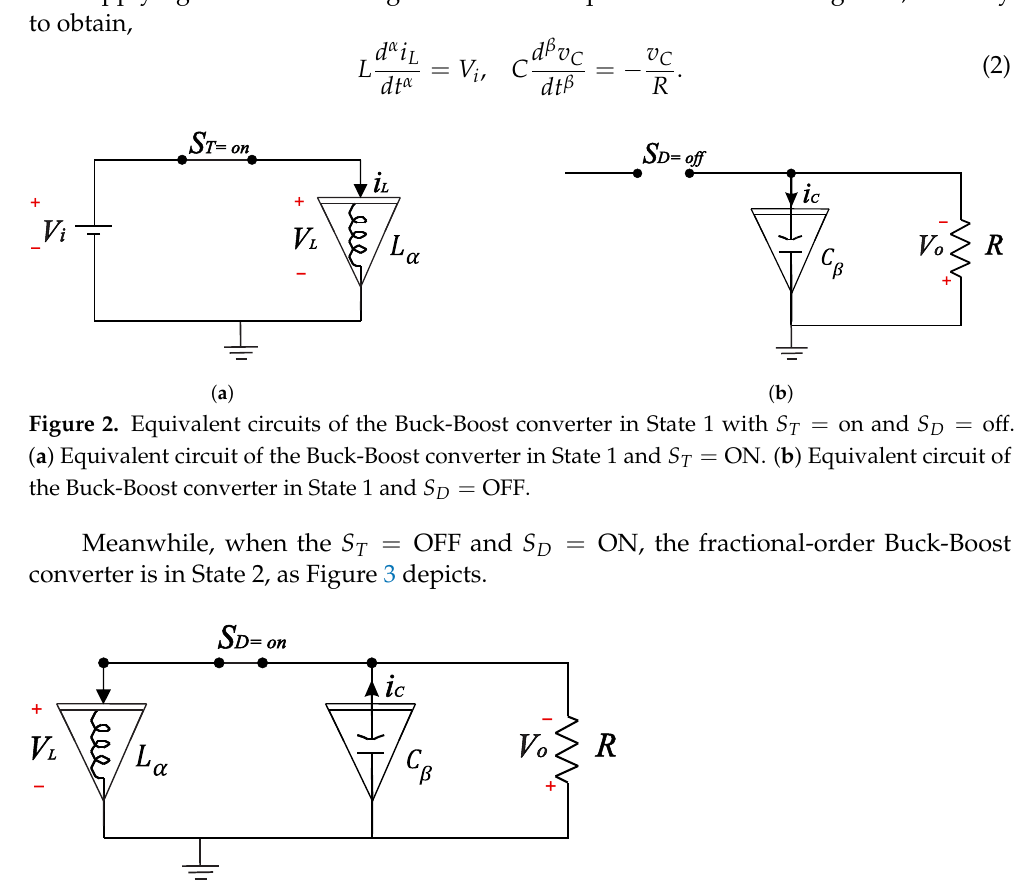
Figure 3. Equivalent circuit of the Buck-Boost converter in State 2 with S T = OFF and S D =